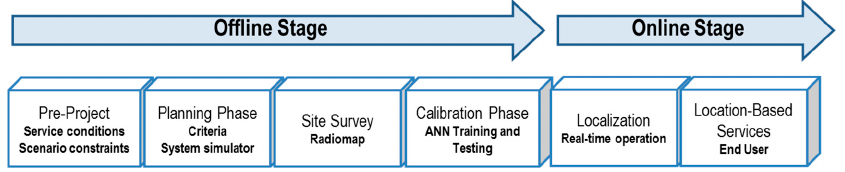
Figure 2. System deployment cycle.